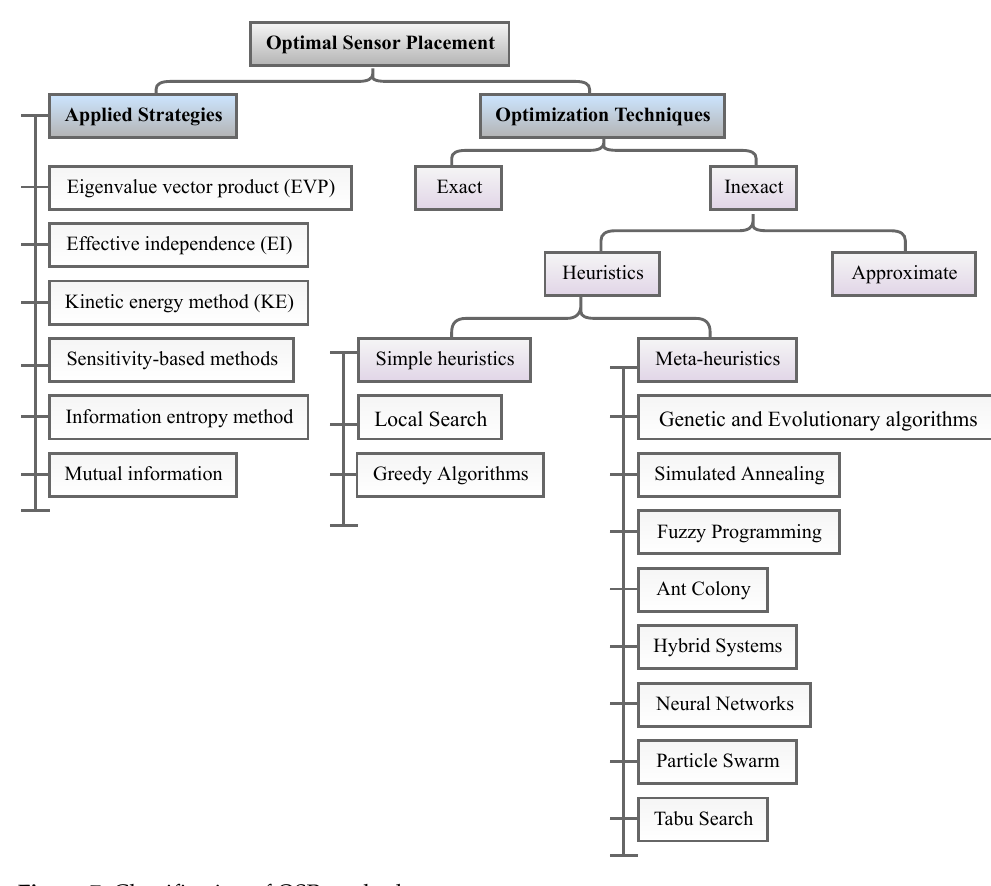
Figure 7. Classification of OSP